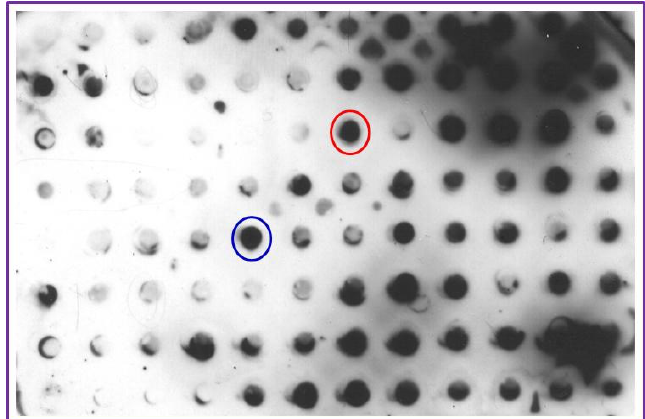
Figure 2. Hybridoma screening for capture and detection antibody selection: LPGDS (pure protein 20 ng) was transferred to PVDF membrane using a Bio-Rad dot blot apparatus and probed with ascitic fluid generated from culturing different hybridoma clones against LPGDS. The membrane was developed using ECL detection kit. Dark dots indicate positive interaction. Positive antibody from red circle was designated as Antibody 1 (AB1) and that in the blue circle is designated as Antibody 2 (AB2) for use in the biomarker detection method. Other clones showed specificity at different levels and these can also be used to detect LPGDS. AB1 and AB2 were selected based on their strong interaction with